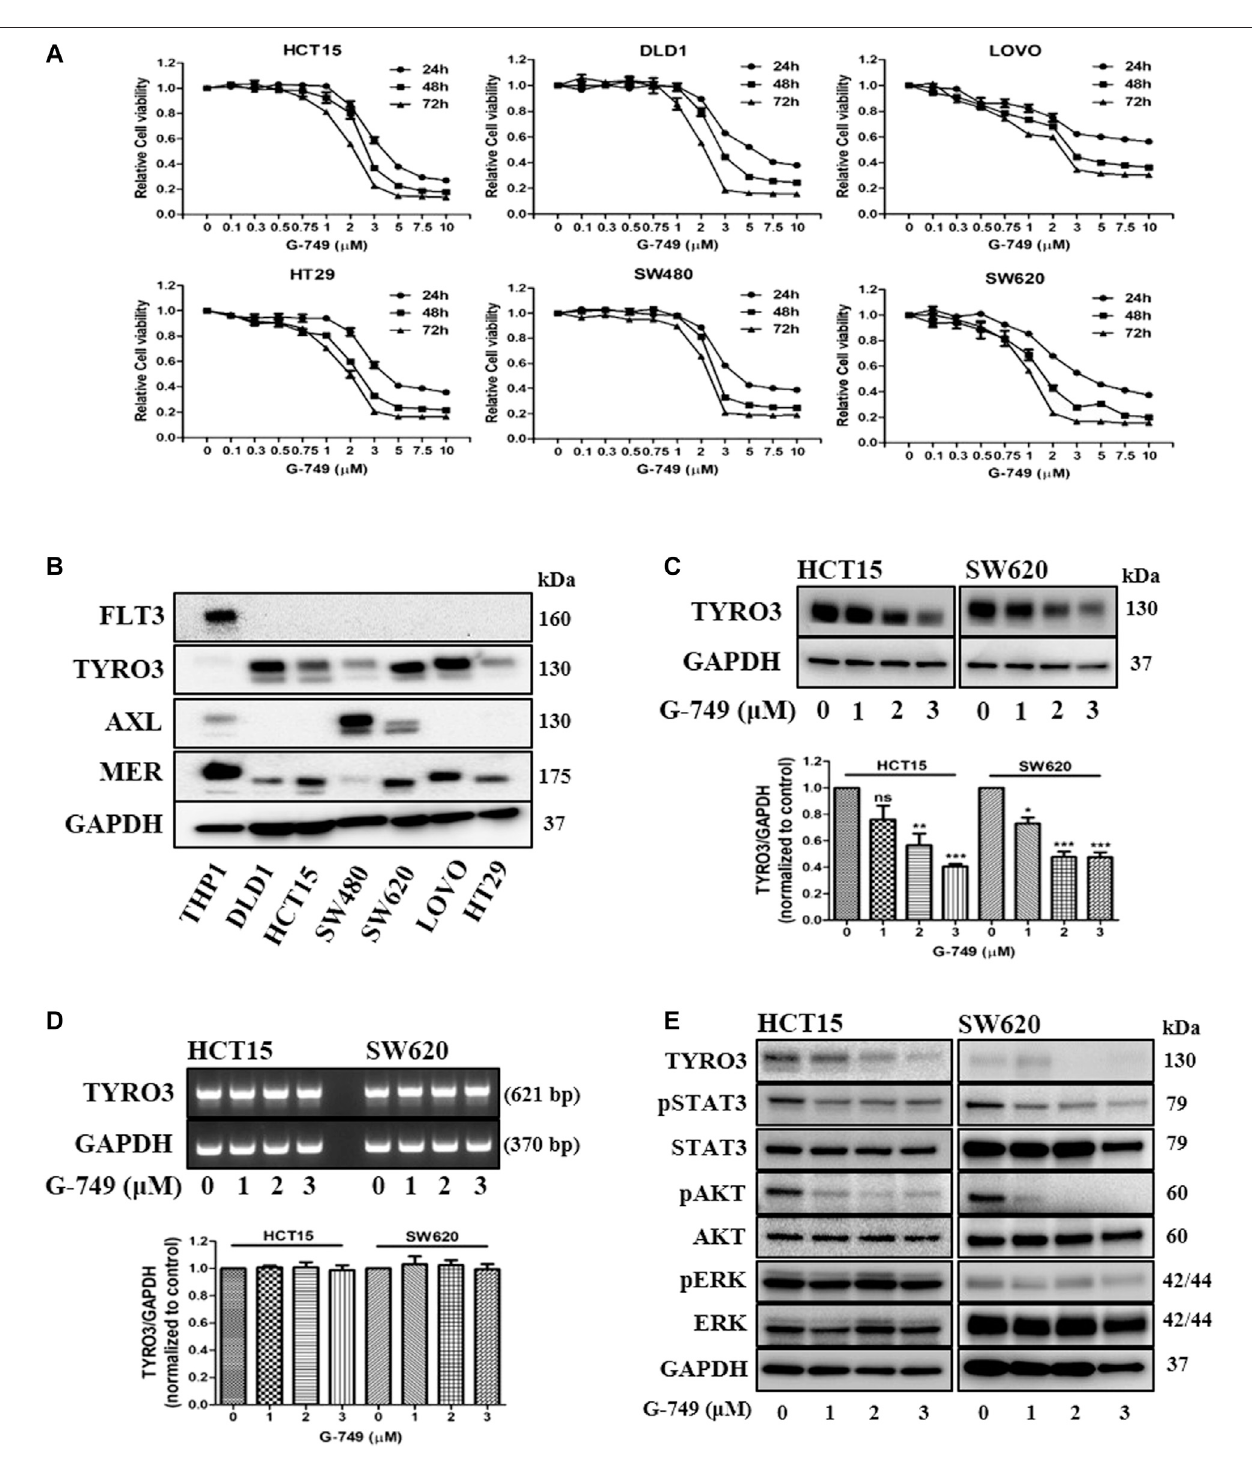
FIGURE 1 | Anticancer effects of G-749 in colon cancer cell lines. (A) The viabilities of the colon cancer cell lines were measured using an MTS proliferation assay. Cells were treatedwithG-749attheindicatedconcentrationsfor24,48,and72 h. (B) ExpressionofTAMreceptorsandFLT3kinasewasanalyzedviawesternblotusinganti-TYRO3,-AXL,-MER, -FLT3andGAPDHantibodies. (C) HCT15andSW620cellsweretreatedwithG-749(1,2,or3 μ M)orDMSOfor24h.Equalamountsofcelllysatesweresubjectedtoelectrophoresis andanalyzedviawesternblottodetectTYRO3levels.GAPDHwasusedasaloadingcontrol. (D) RNAlevelsweredeterminedbyRT-PCRanalysis.HCT15andSW620cellswere treatedwithG-749(1,2,or3 μ M)orDMSOfor24h.GAPDHwasusedasacontrol. (E) CellsweretreatedwithG-749attheindicatedconcentrationsfor24 h.Equalamountsofcell lysateswerethensubjectedtoelectrophoresisandanalyzedviawesternblotusinganti-TYRO3,-phospho-STAT3,-STAT3,-phospho-AKT,-AKT,-phospho-ERK,-ERK,and-GAPDH antibodies.GAPDHwasusedasaloadingcontrol.ThebargraphwasgeneratedbyquantifyingblotsfromthreeindependentexperimentsusingImageJandnormalizingtheintensityof the bands to the control. Data are presented as means ± standard deviations (SD). Data were analyzed using one-way ANOVA with Tukey ’ s multiple comparison post-hoc analysis; **** p < 0.0001, *** p < 0.001, ** p < 0.01, * p < 0.05. Frontiers in Pharmacology |